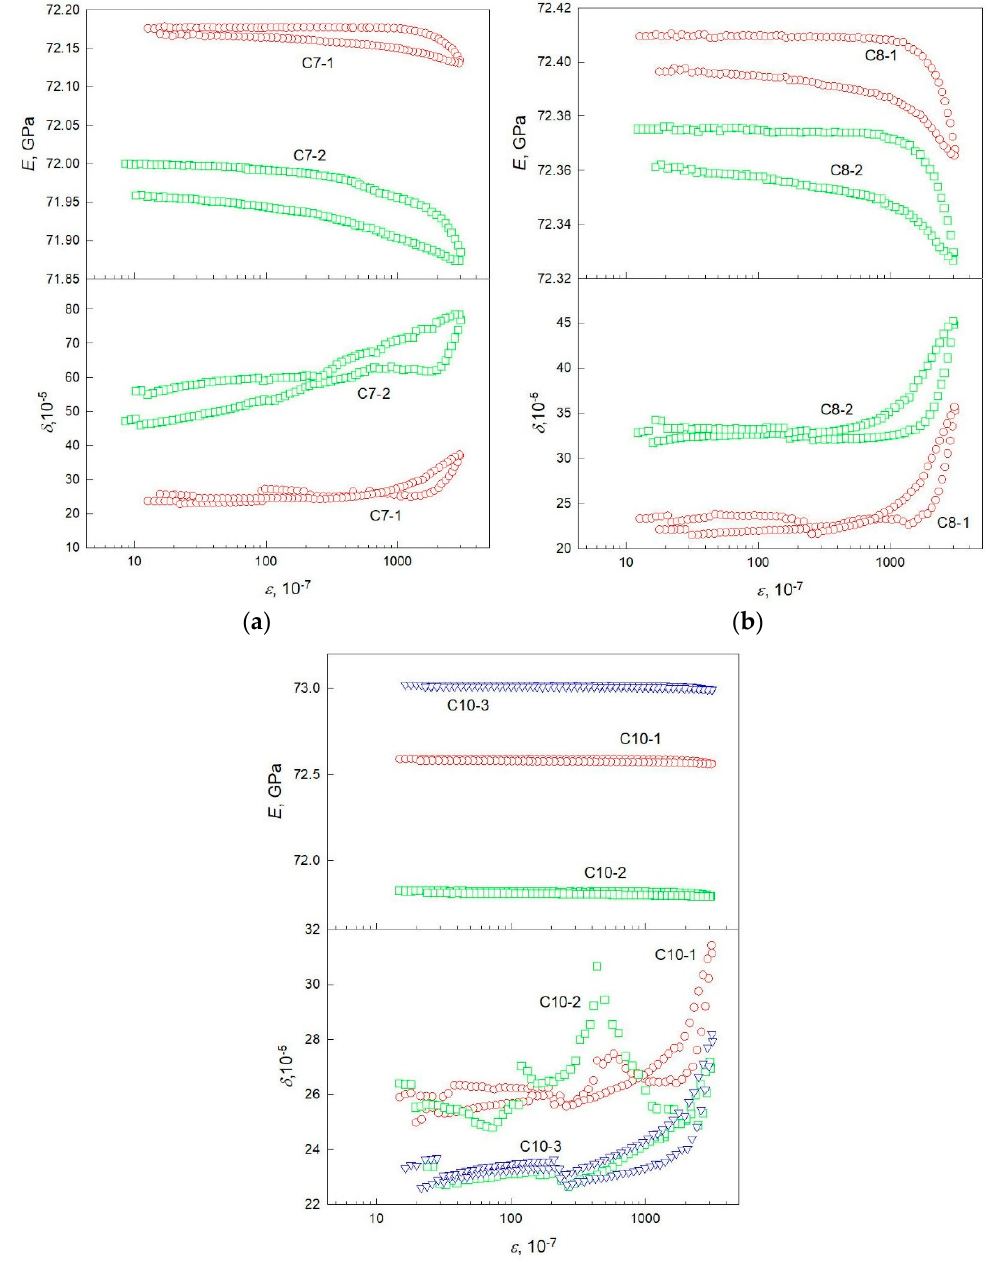
Figure 13. Amplitude dependences of Young’s modulus E , and decrement δ of aluminum wires after fatigue tests for samples ( a ) C7-1 and C7-2, ( b ) C8-1 and C8-2, and ( c ) C10-1, C10-2, and C10-3. The measurements were made at the room temperature.